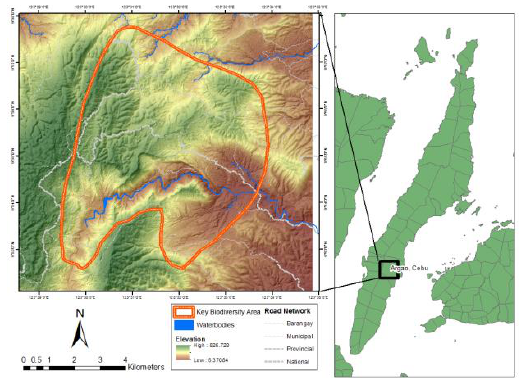
Figure 1. Study Site: Mt. Lantoy Key Biodiversity